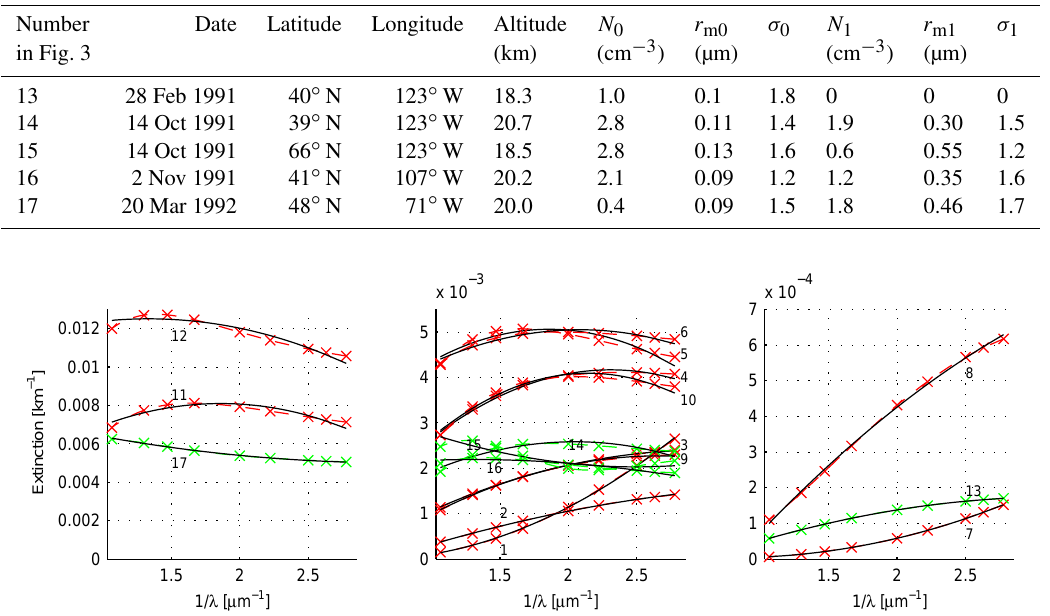
Table 4. Stratospheric aerosols: bimodal lognormal particle size distribution parameters N 0 and N 1 (aerosol total number density), r m0 and r m1 (mode radius), and σ 0 and σ 1 (mode width), representative of the period just before and after the Pinatubo eruption. The data were obtained from impactor samples on an ER-2 aircraft and were published by Pueschel et al. (1994) (Table 1a). For optical calculations, we used a H 2 SO 4 weight percentage of 78%, corresponding to a temperature of 217K. Examples of refractive indices: 1.47 (400nm), 1.46 (600nm).